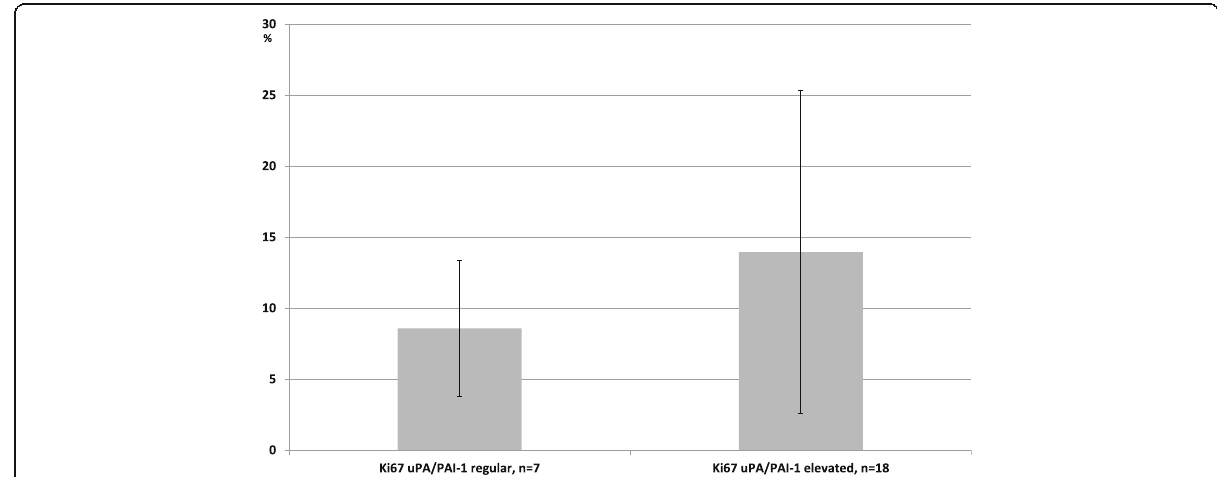
Fig. 1 Average of Ki67-Index (MIB-1) in %; breast cancer with regular and elevated uPA and/or PAI-1 (8.5 vs. 13.9%). p = 0.054, Student ’ s